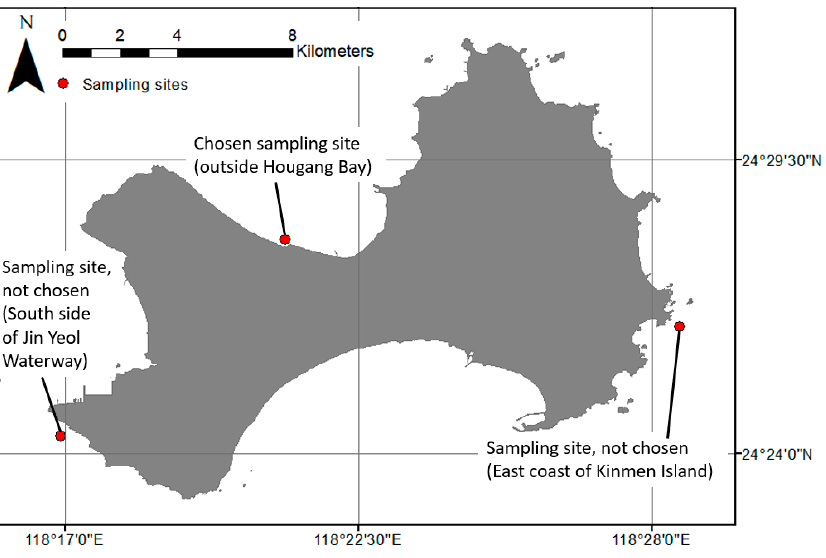
Figure 4. Location of water quality sampling sites near the main island of Kinmen.